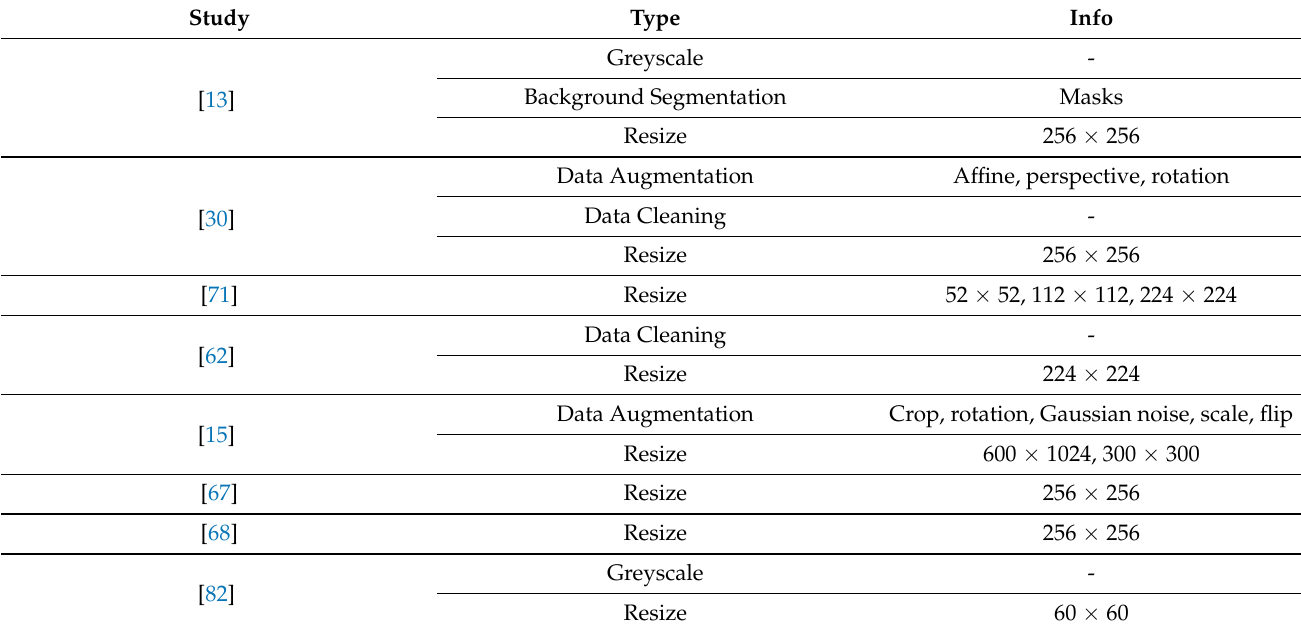
Table 2. Pre-processing when deep learning techniques were